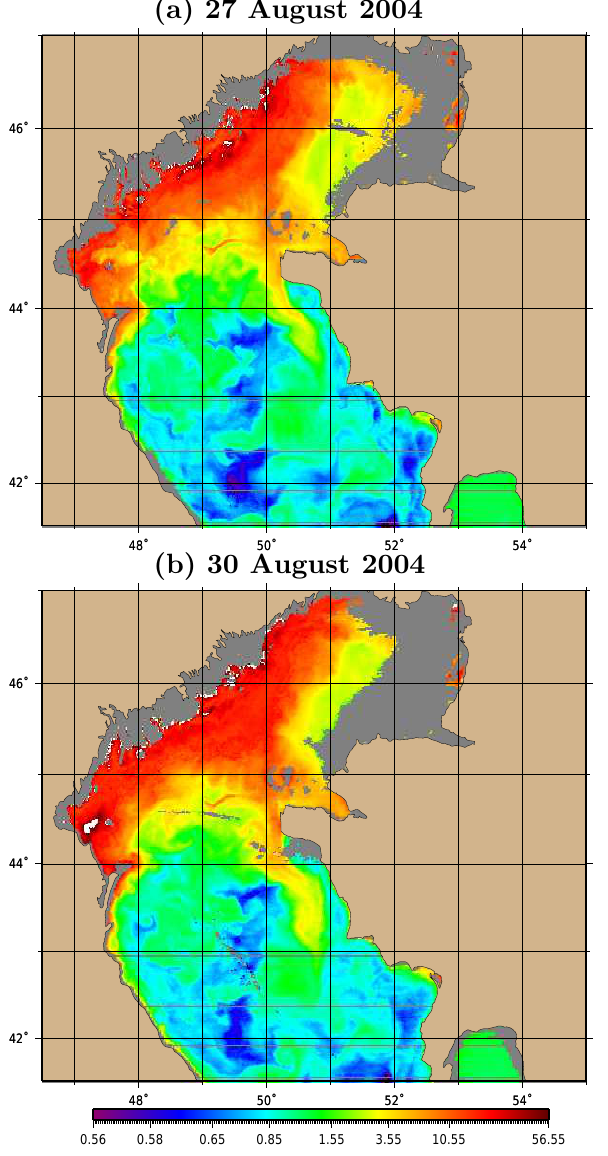
Figure 2. The Caspian Sea model bathymetry.